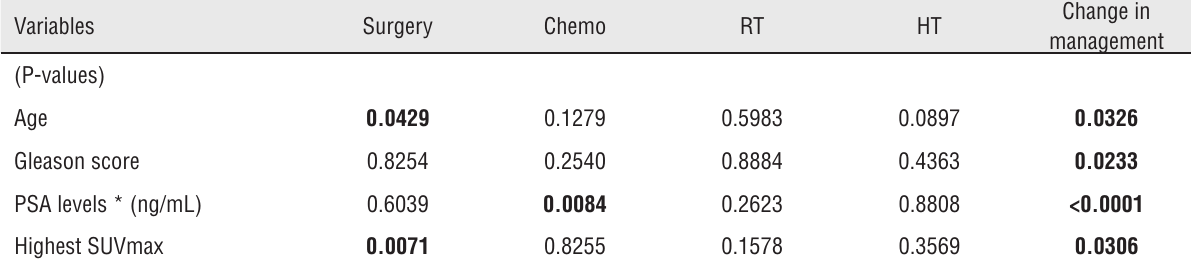
Table 3 - patient and 68 Ga-pSMA pET/cT characteristics in comparison to treatment types (surgery, radiotherapy, etc) and its impact in patient